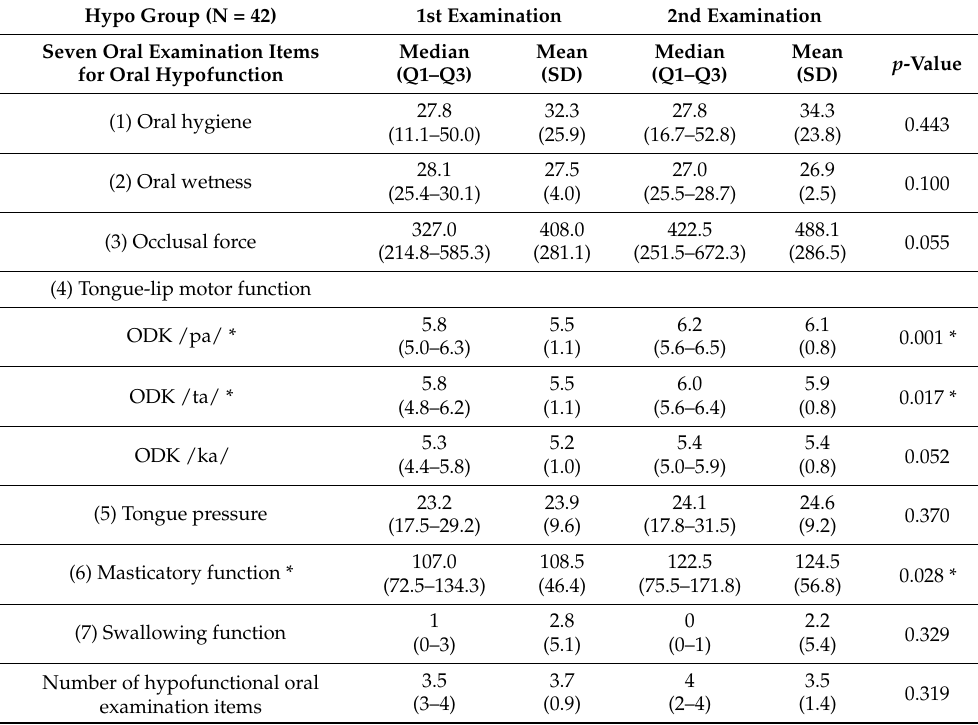
Table 2. Temporal changes in oral function between the 1st and 2nd examination in the Hypo group.